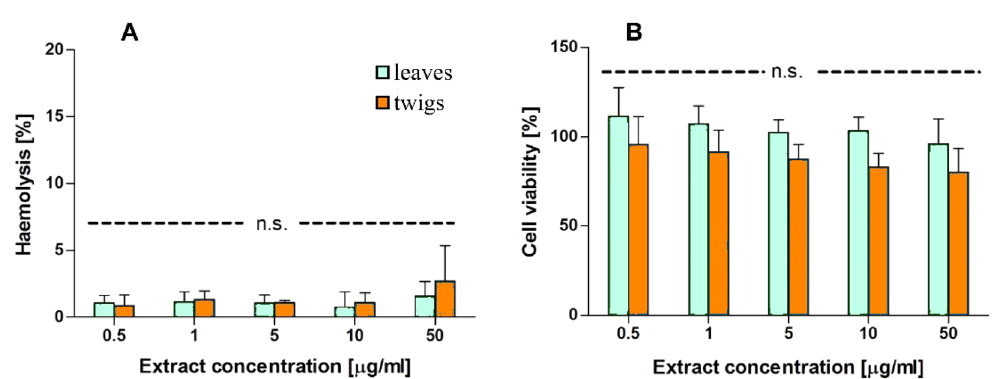
Figure 4. ( A ) The hemolytic activity of the Hippophae rhamnoides L. leaf and the twig extracts after 24 h incubation. ( B ) The viability of the BJ cells in the presence of Hippophae rhamnoides L. extracts at the concentration ranged from 0.5 to 50 μg/ml. Incubation time 24 h. The data represent mean ± SEM of three independent repetitions. Ns—not statistically